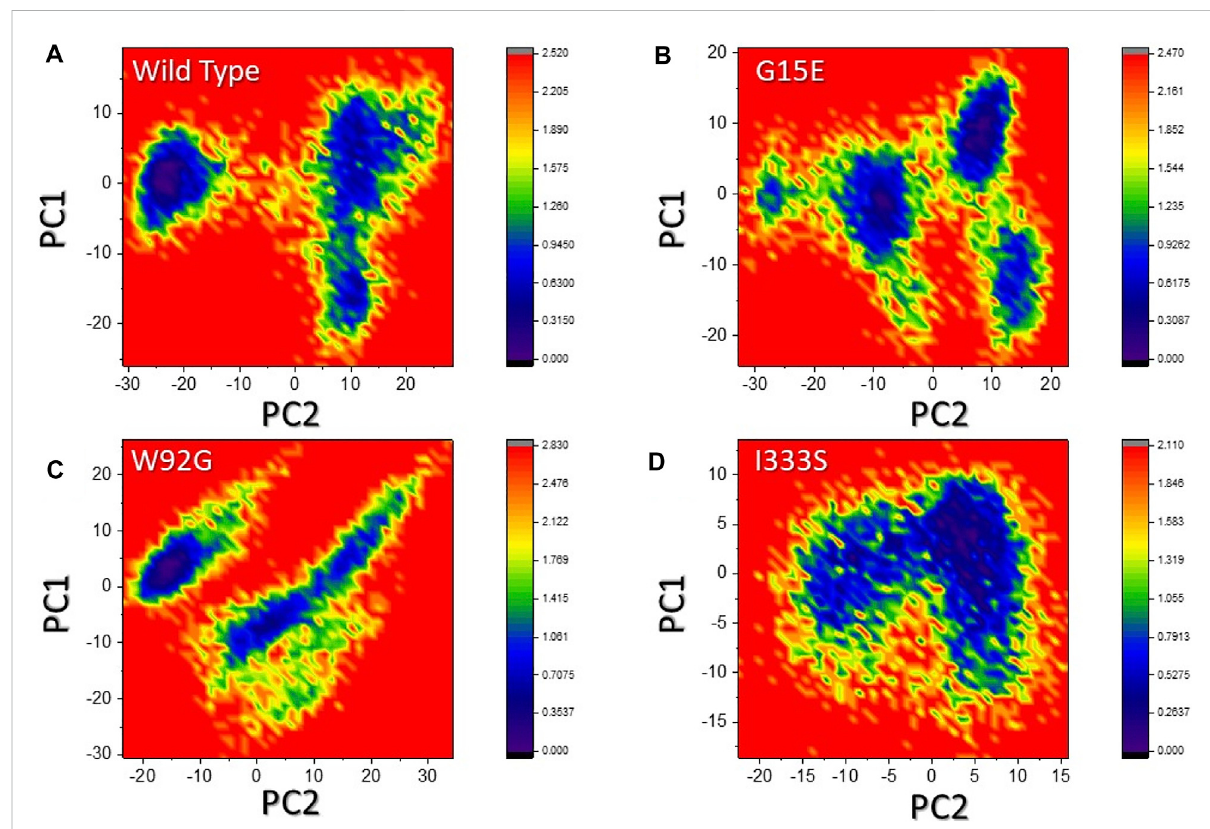
FIGURE 9 Free energy landscape analysisof thewild-type and mutantcomplexes. (A )Representation ofDEL ofthe wildtype. (B) Representation ofFELof G15E. (C) RepresentationoftheFELofW92G. (D) RepresentationoftheFELofI333S.Thedarkregionsineachshowthelowest-energyconformation where the conformational states are separated by subspace in each complex.